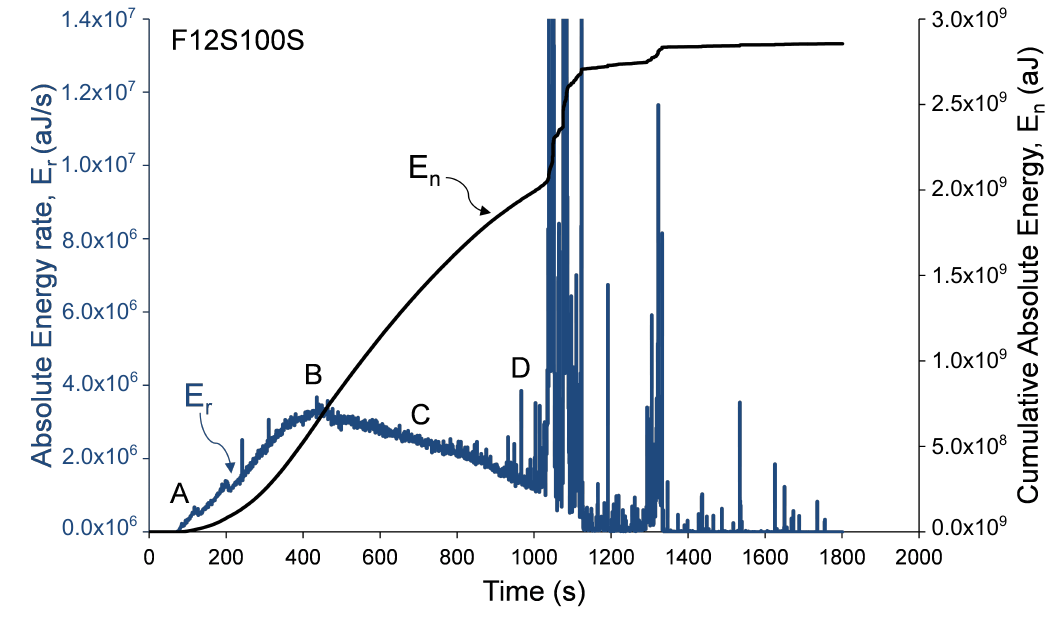
Figure 7. Absolute and cumulative absolute energy versus time—specimen F12S100S.